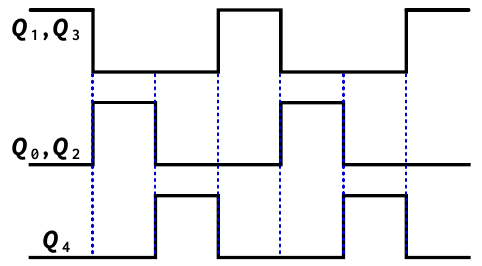
Figure 7. Switching sequences of the proposed equalizer at V B 0 < V B 1 .